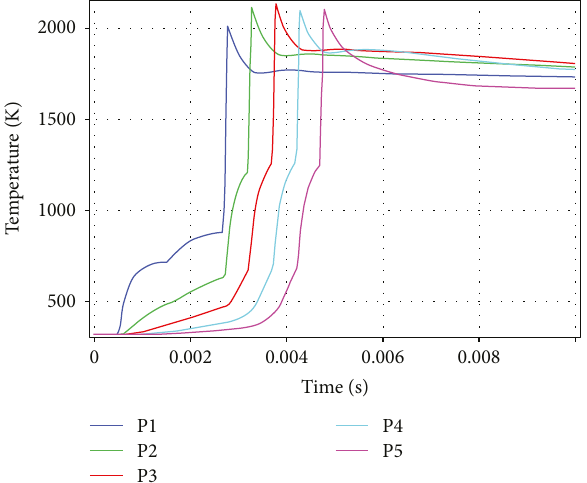
Figure 9: Temperature variation curves of P1, P2, and P3.